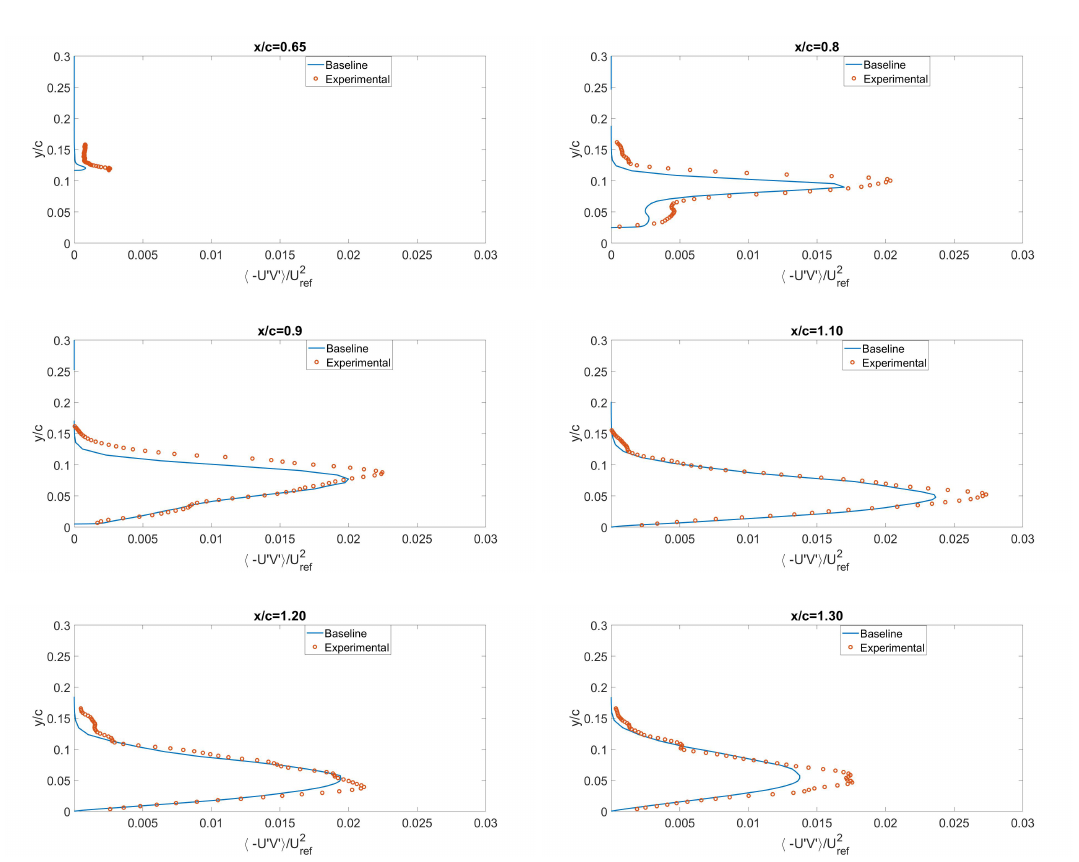
Figure 13. Normalized mean Reynolds stress along y/c at different streamwise locations.